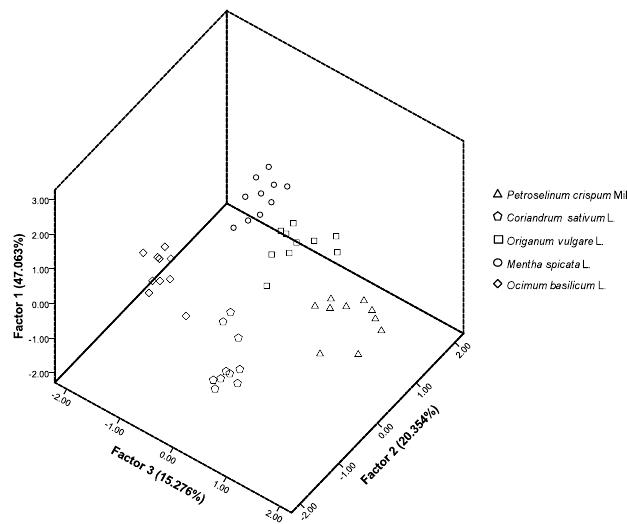
Fig. 3: Principal component analysis obtained from the morphological pa- rameters of five different aromatic and medicinal plants. PCA fac- tors explain 82.692% of the total variance.